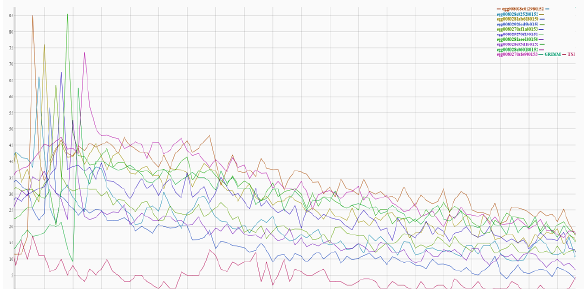
Figure 5. Comparison of sensitivity and precision of individual AQEggs measuring PM 10 (1-minute aggregation) [μg.m -3 ] during an indoor testing setup